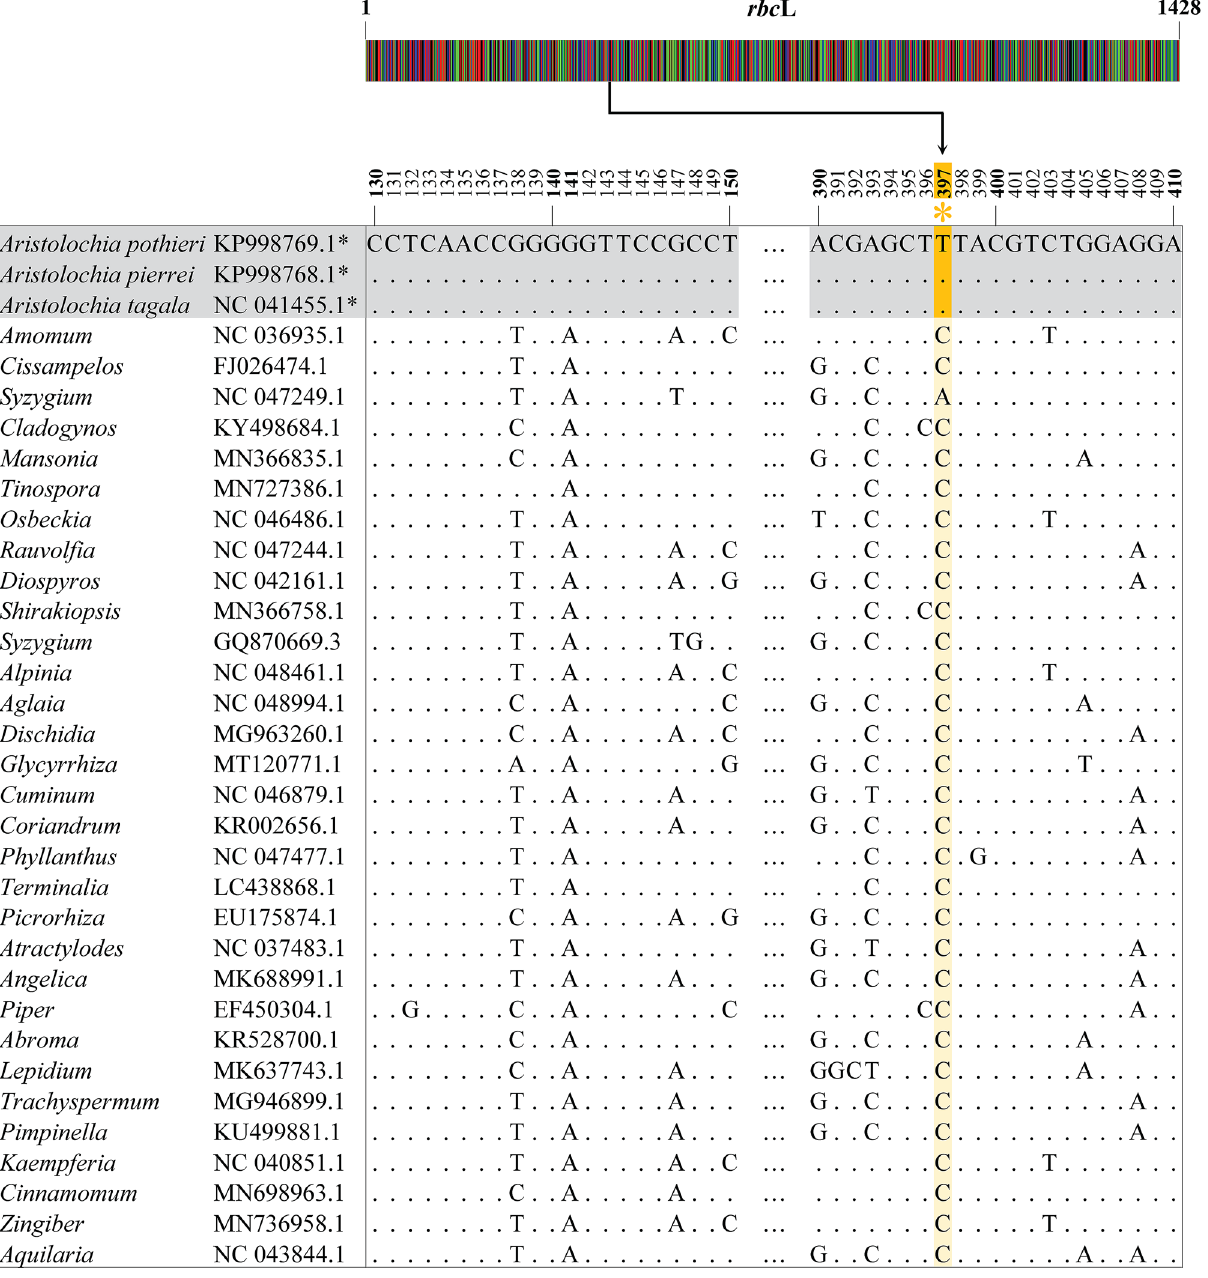
Figure 2. Alignment of the partial rbc L sequences of the selected Aristolochia spp. and non- Aristolochia plants. The nucleotide signature of Aristolochia plants is colored yellow. Asterisks indicate nucleotide signatures that target the specific primer. Consensus sequences are indicated with dots. The altered bases indicate the sequence